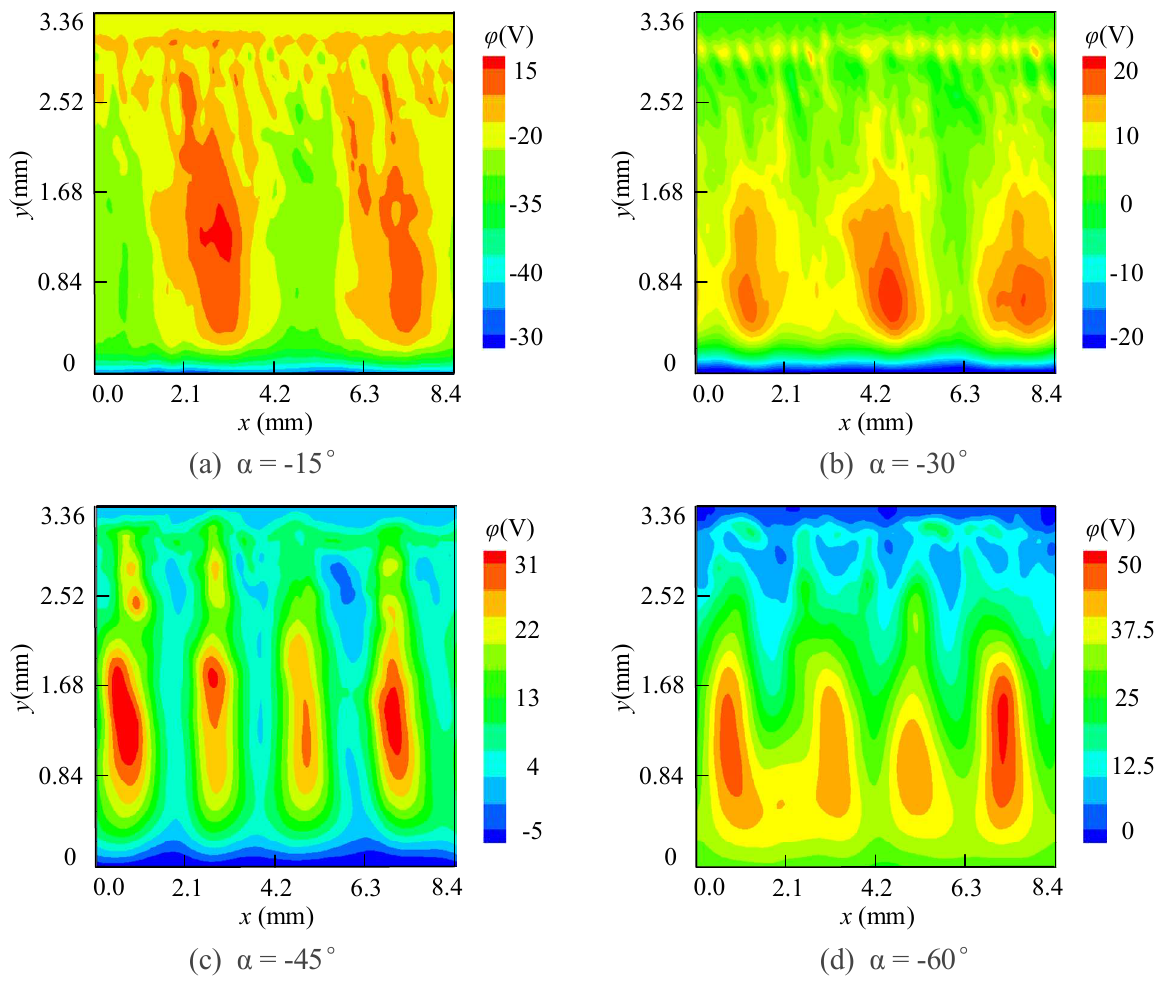
Figure 11. The 2D distributions of electric potential with different values of the negative α .